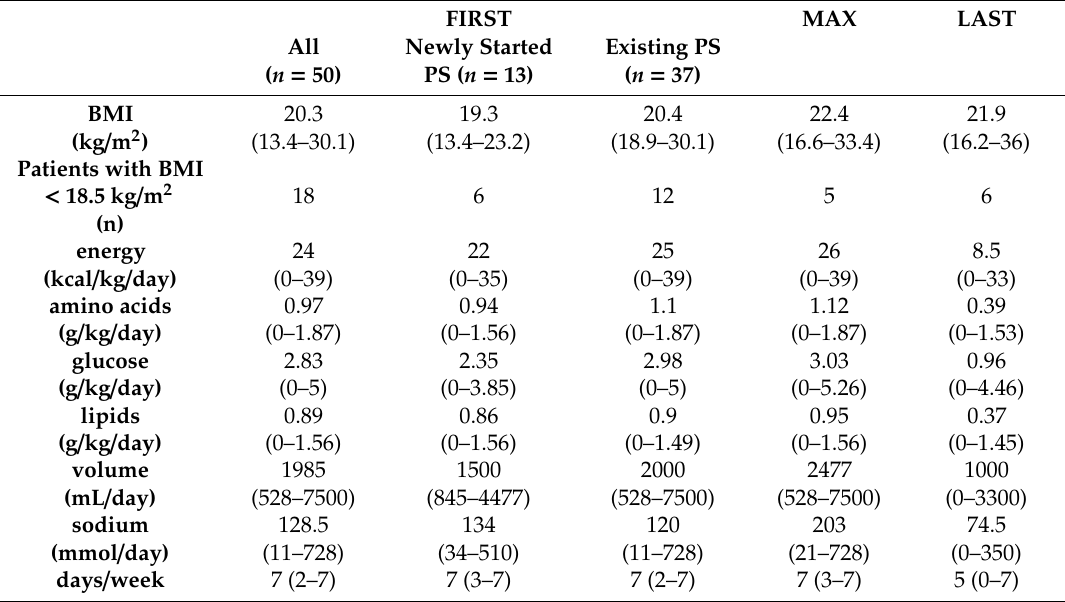
Table 2. Composition of parenteral support (PS) at time points FIRST, MAX, and LAST in the entire cohort. For the time point FIRST the cohort is stratified into patients who were newly started on PS and patients who were referred with existing PS. Median (min–max).